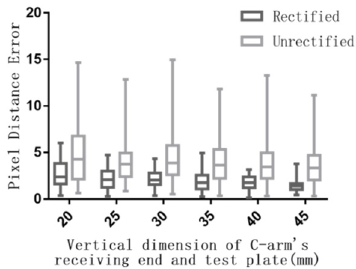
Figure 11. Error statistics of rectified and unrectified X-ray image.